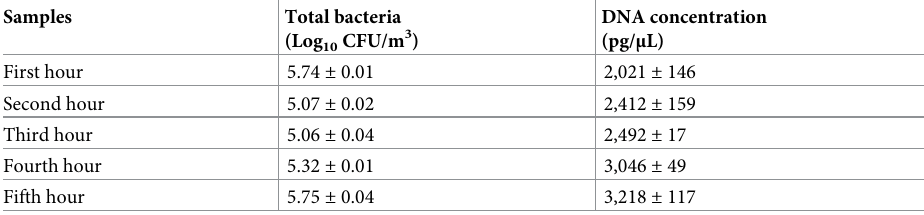
Table 3. Total bacteria and DNA concentration in the air sampled in an empty weaning room over five hours. Data reported as mean ± standard error of mean (SEM), number of replicates (n) = 2.